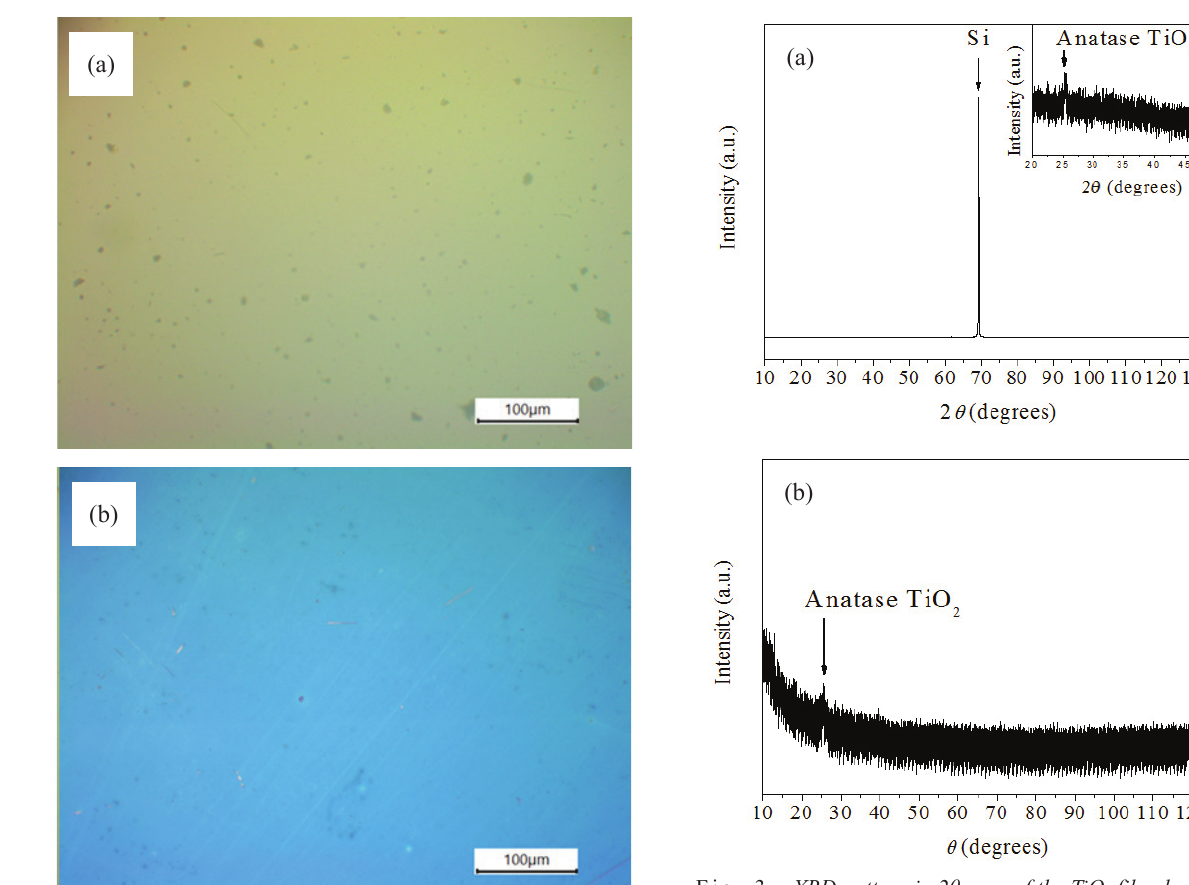
Fig. 3 – XRD pattern in 2θ scan of the TiO film deposited by 2 sol-gel (the inset is the enlarged view of the diffrac- tion peaks from 20° to 60°) (a) and XRD pattern of film in grazing-incidence low θ angle the TiO 2